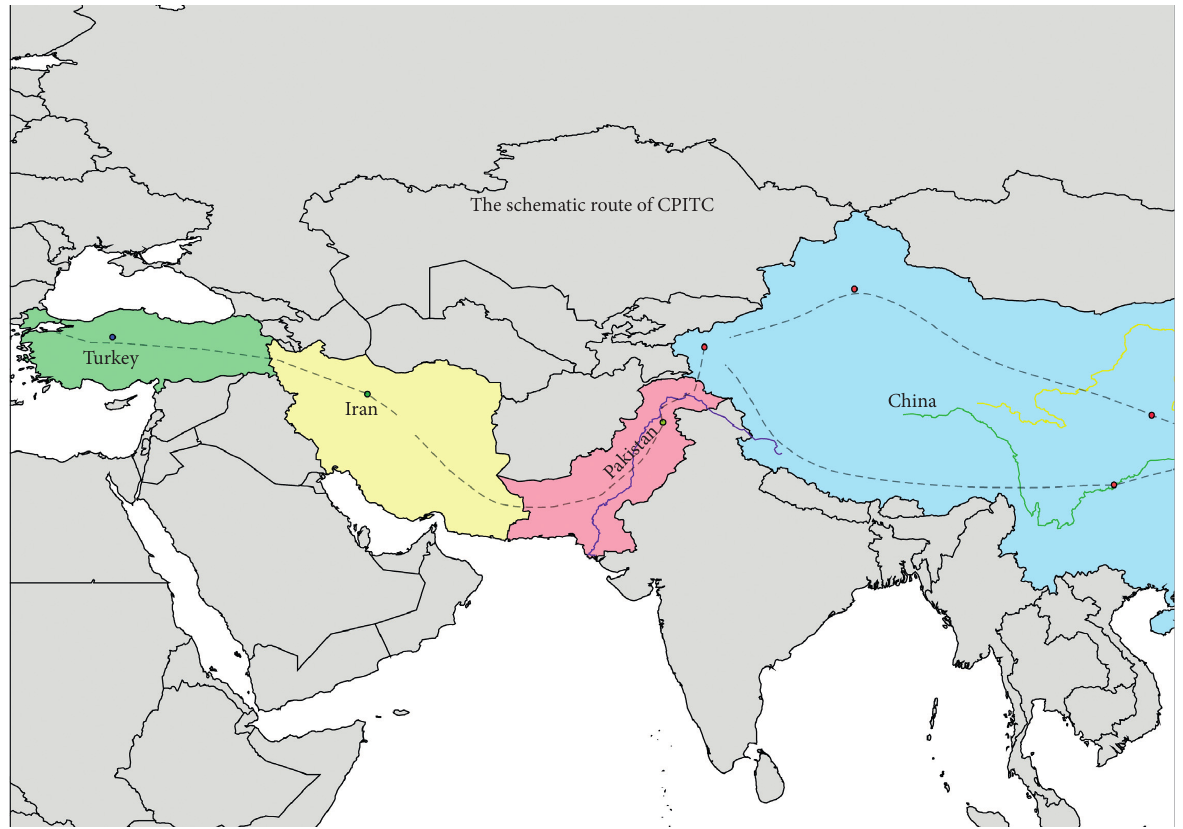
Figure 2: The schematic route of CPITC. Source: The Geography of Transportation Systems (by Jean-Paul Rodrigue, Claude Comtois, and Brian Slack).